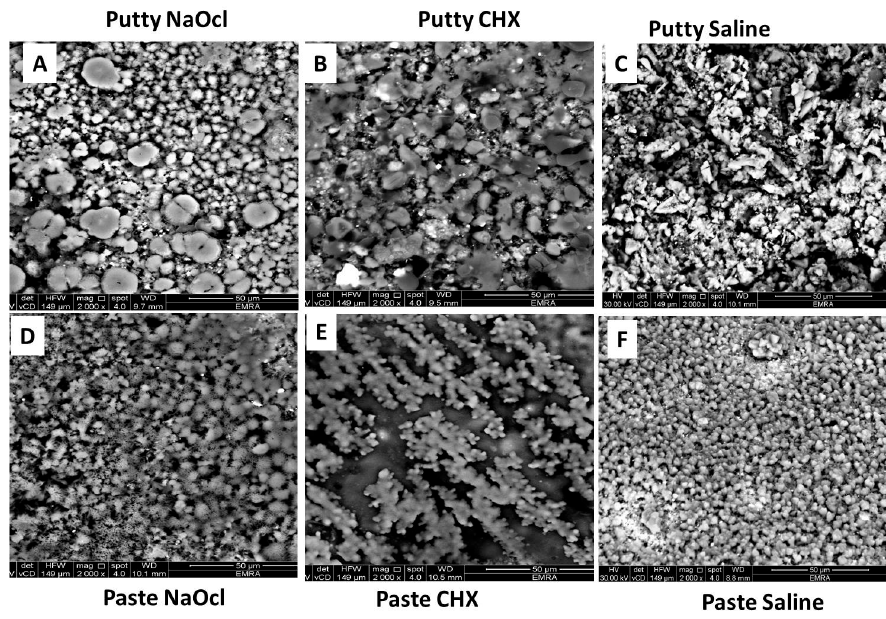
Figure 3. Scanning Electron Microphotographs of surface topography of putty ( A , B, and C ), paste ( D , E, and F ) root repair materials after immersion in 5.25% sodium hypochlorite, 2% chlorhexidine gluconate, and saline, respectively.